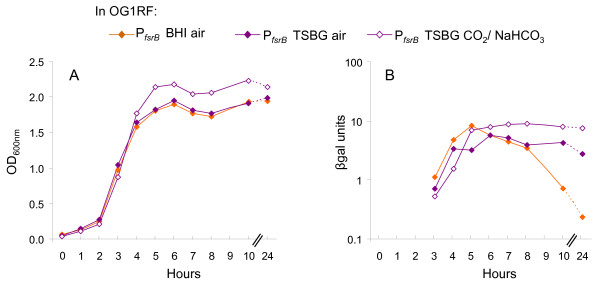
fsrB expression profile in OG1RF. For β-gal assays, samples were collected every hour from 3 to 8 hr, then at 10 and 24 hr after starting the culture (x axis). All sets of cultures presented were analyzed concurrently. The figure is a representative of at least two experiments. The growth curves are represented in brown for cells grown in BHI-air and purple for cells grown in TSBG (thin line when grown in air, dense line when grown in the presence of 5% CO2/0.1 M NaHCO3). OG1RF containing PfsrB::lacZ was grown in BHI air (brown closed diamond), in TSBG- air (purple closed diamond) or in TSBG-5% CO2/0.1 M NaHCO3 (purple open diamond). A. OD600 nm readings. B. β-gal assays (β-gal units = OD420 nm/protein concentration in mg/ml).